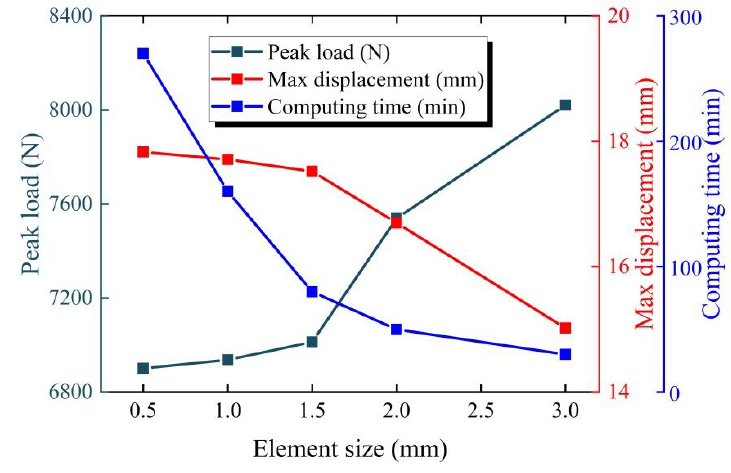
Figure 3. Mesh convergence